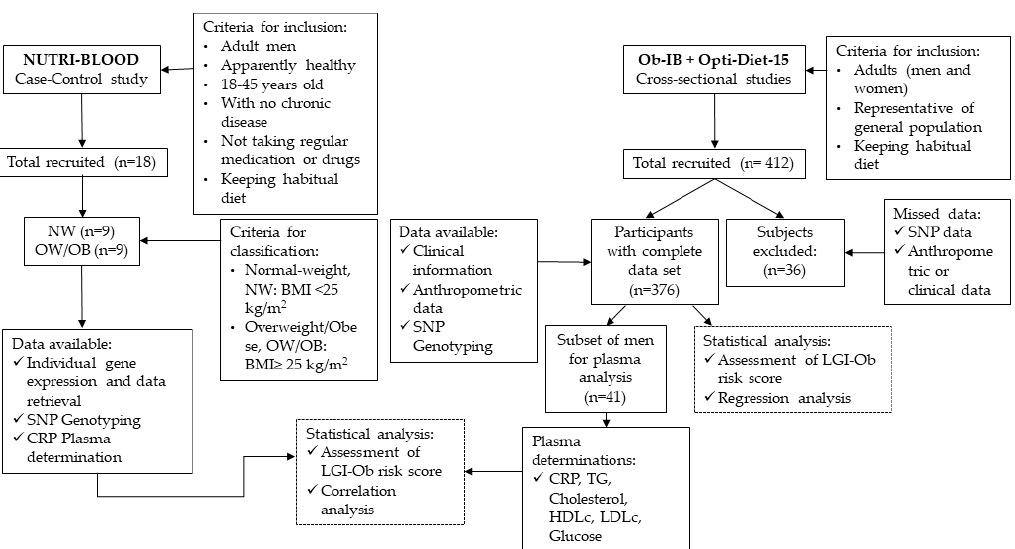
Figure 1. Flowchart diagram showing the main characteristics of the genetic association study to build up the score of predisposition to low-grade inflammation associated with obesity (LGI-Ob). This is based on three observational studies: One case-control (NUTRI-BLOOD), and two cross-sectional (OptiDiet-15 and Ob-IB) studies. NW (Normo-weight); OW/OB (Overweight/Obese); SNP (Single Nucleotide Polymorphism); CRP (C-reactive protein); BMI (Body Mass Index); TG (Triglyceride); HDLc (Cholesterol-High Density Lipoprotein); LDLc (Cholesterol-Low Density